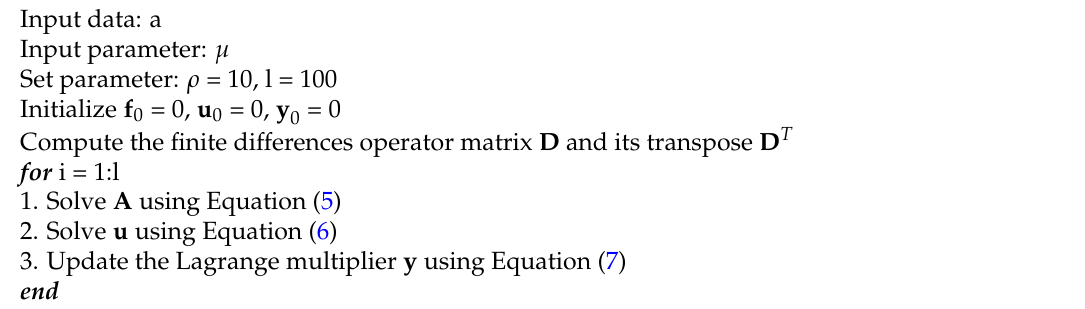
Algorithm 1 Pseudo code for FFT operation-based data smoothing